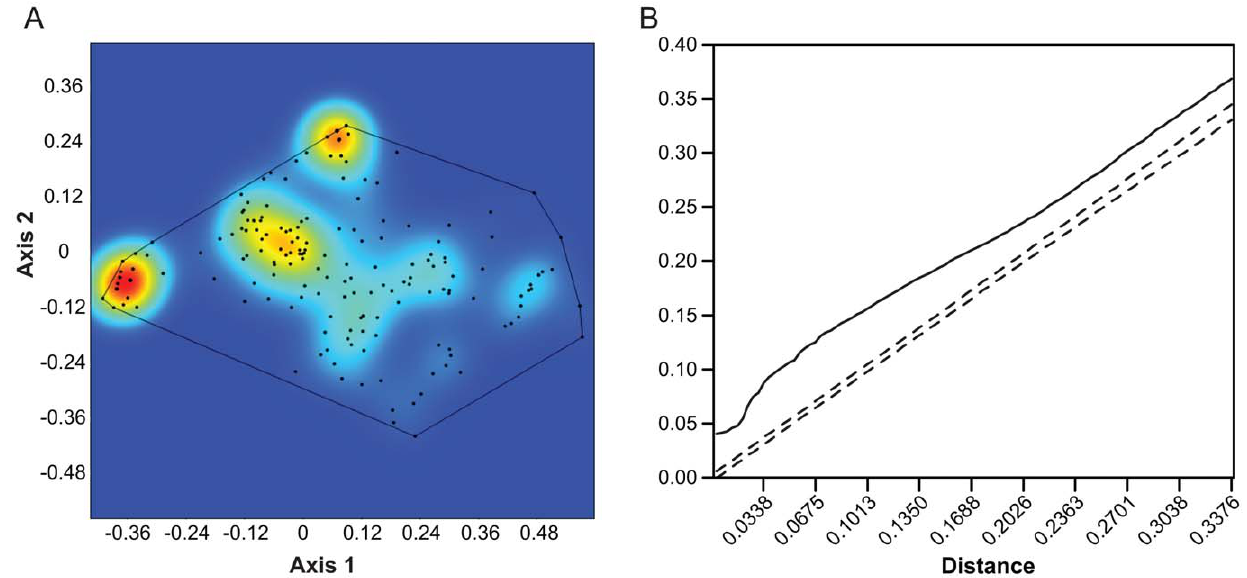
Figure 2. Point pattern analysis of the morphospace occupation pattern seen in Figure 1. A. Kernel density plot. Three hotspots at the extreme left (hypercarnivores, mostly Felidae), top (long-snouted, full premolar rows, mostly Canidae), and intermediate (Viverridae, Herpestidae, Mustelidae) are clearly in evidence. B. Ripley’s K analysis of the patterns seen in Figure 2A. The x-axis represents inter-point distances, the y-axis the K- value. The dotted lines are the 95% confidence envelope of complete spatial randomness (CSR), while the solid line shows the actual values obtained. Values above the confidence envelope indicate significant attraction between points; values below it indicate significant repulsion between points. In the present case there is significant attraction at all distances.